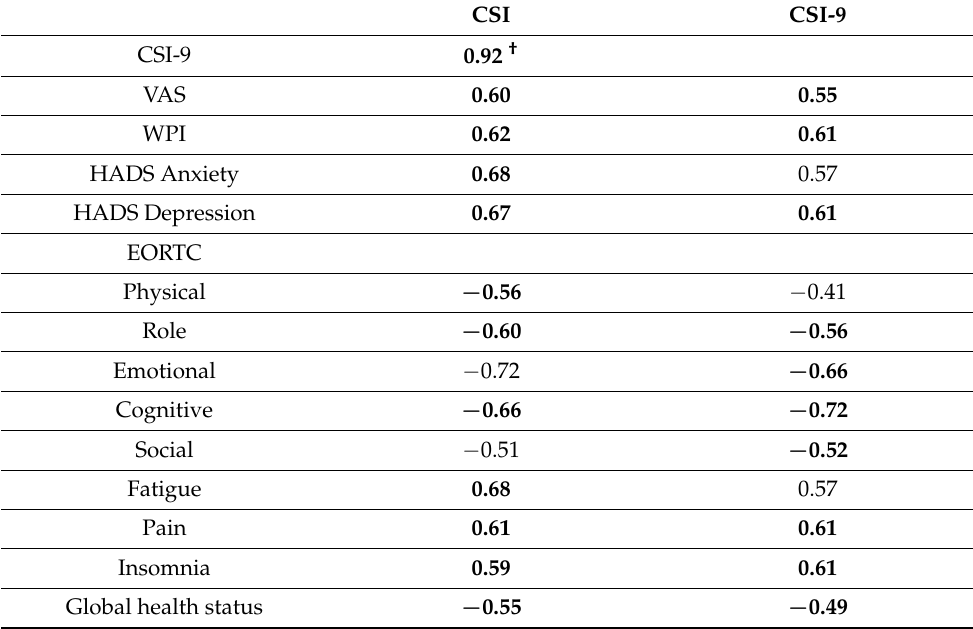
Table 2. Associations with CSI and CSI-9 ( n = 65).